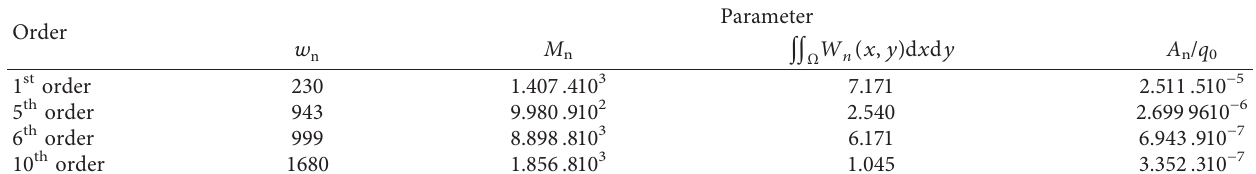
Table 7: The effective vibration modes of the thin plate rock mass under impact load